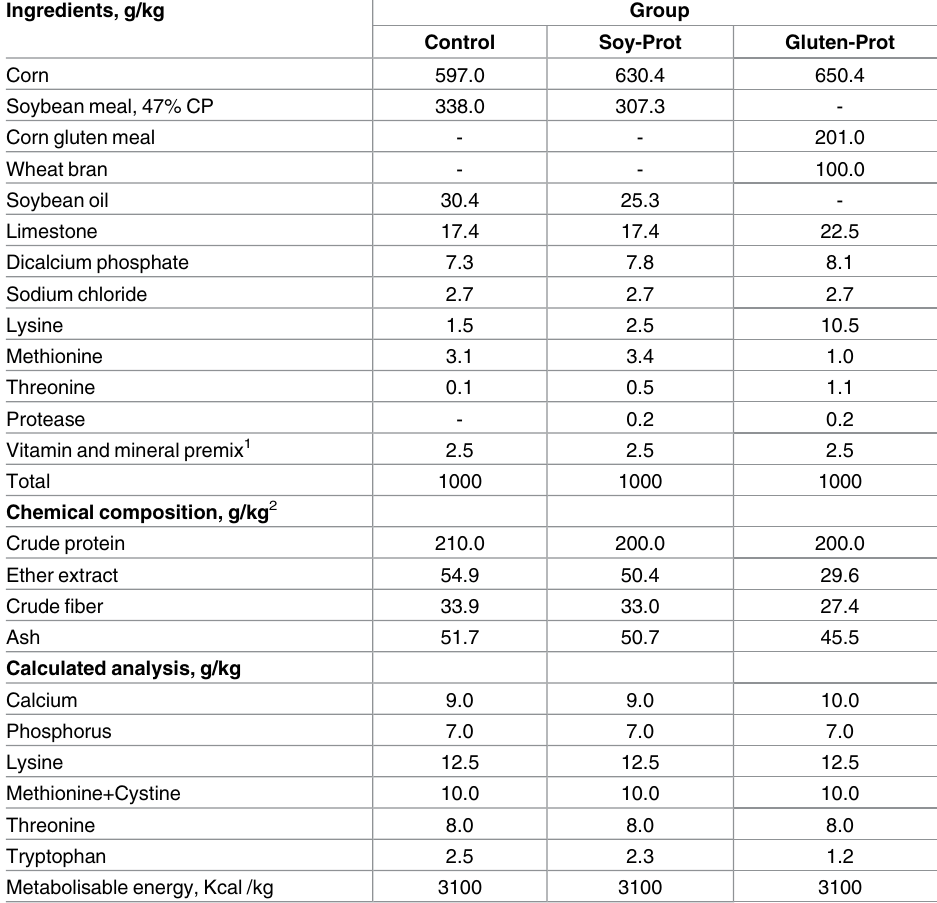
Table 1. Ingredients and chemical composition of diets. Ingredients,